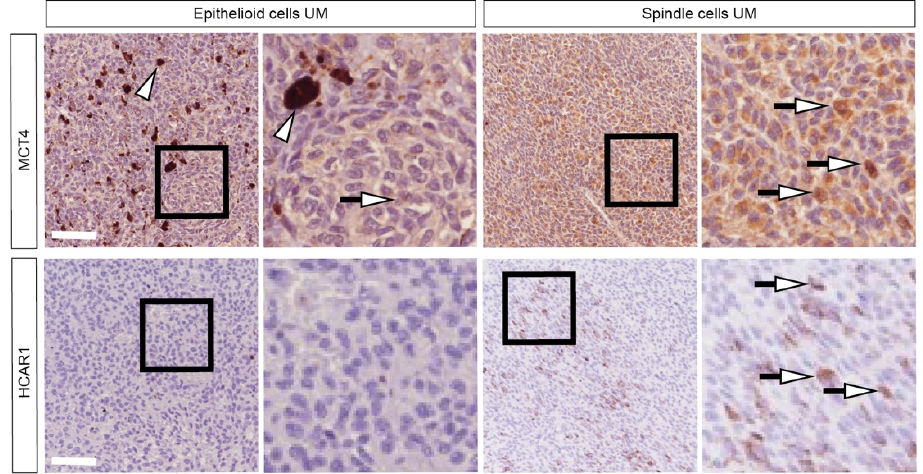
Figure 6. Lactate transporter MCT4 and lactate receptor HCAR1 are overexpressed in advanced UM. Representative pictures of the MCT4 and HCAR1 expression in human biopsies of patients with epithelioid and spindle UM. Arrowheads indicate dark-brown pigmentation and arrows indicate positive staining. Scale bars: 50 μ m.